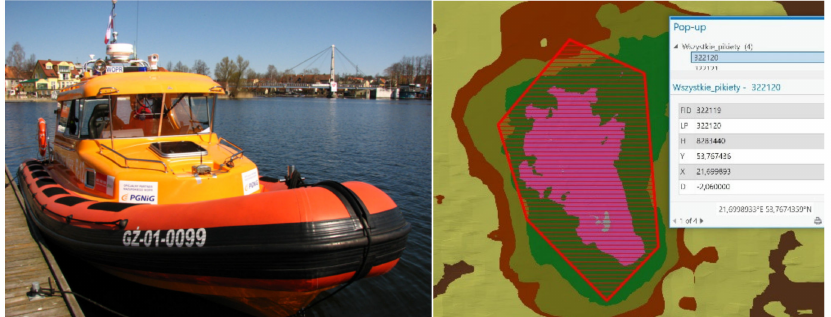
Figure 9. On-site verification of cardinal buoys (measuring platform—Water Rescue Service boat ( left ), the model with depth readings ( right